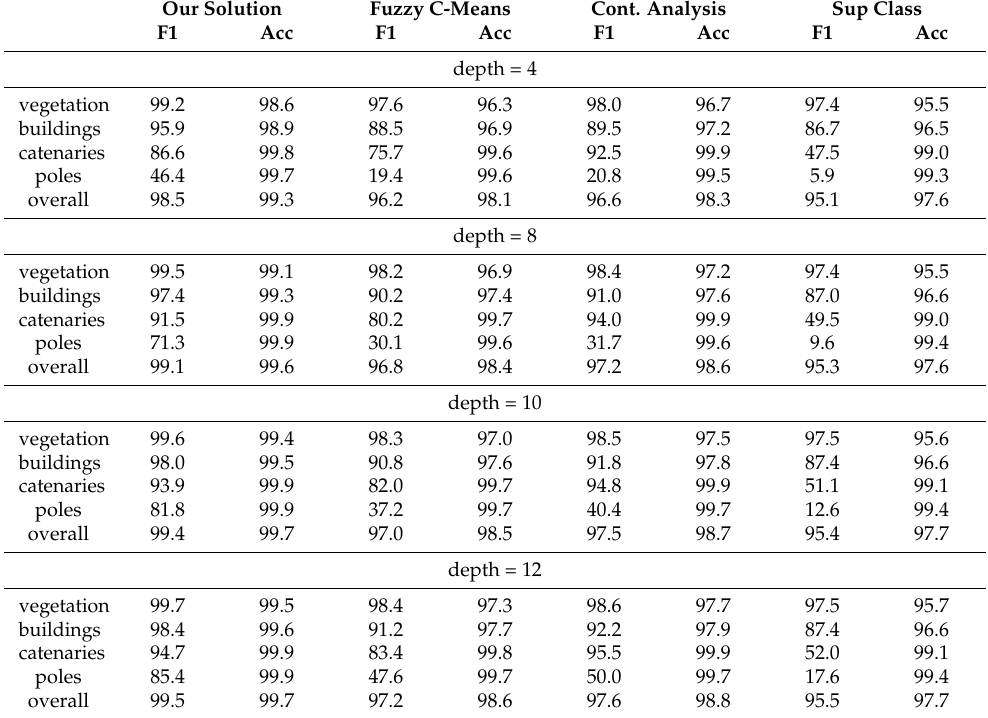
Table 7. F1 and accuracy for different depth levels.